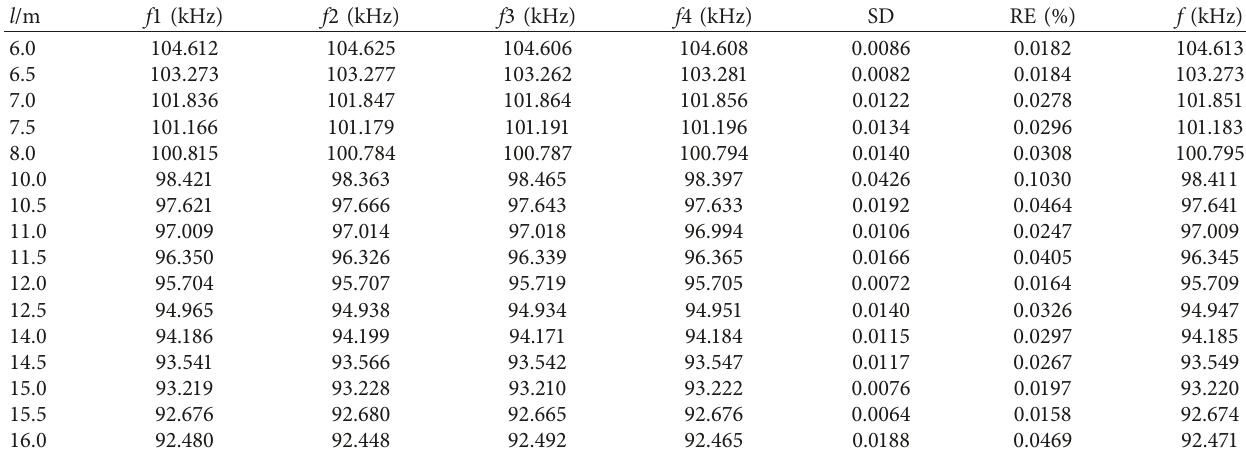
Table 2: V 9mm experimental data of aluminum strands.